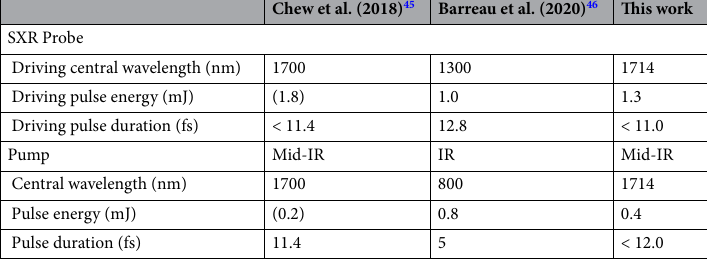
Table 2. ATAS instruments used to measure dynamics in argon at L 2,3 -edges.